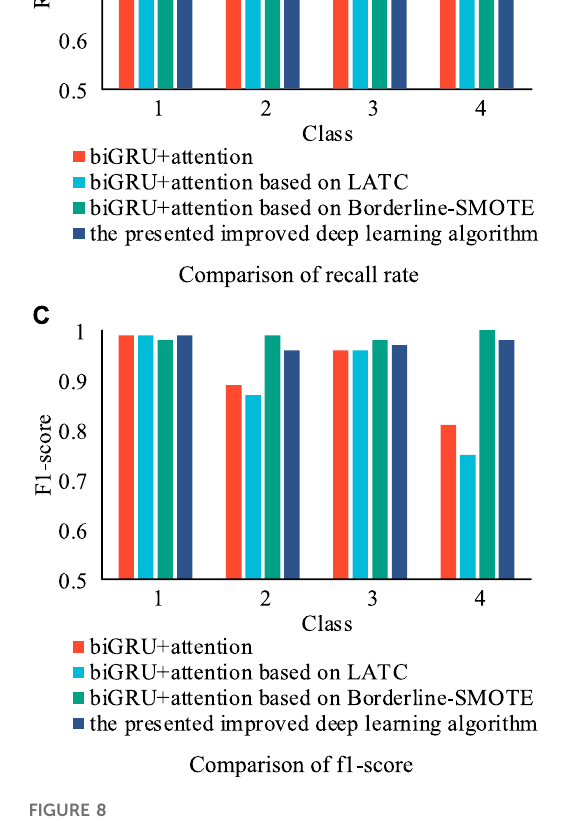
FIGURE 8 The (A) Precision a, (B) Recall Rate and (C) F1-score of different experiments with different classes.